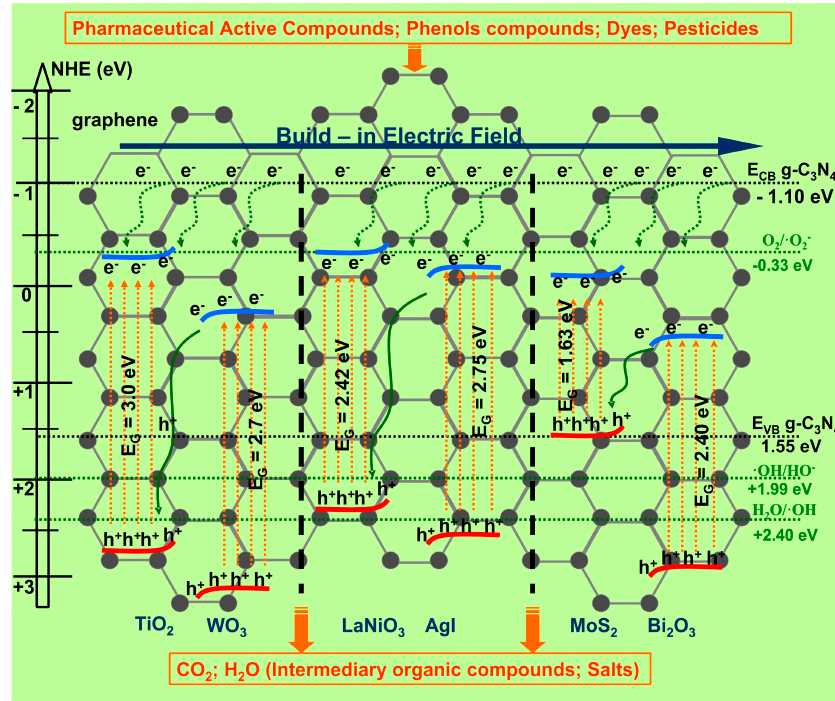
Figure 3. Energy band diagrams of TiO 2 /WO 3 , LaNiO 3 /AgI, and MoS 2 /Bi 2 O 3 S-scheme hetero- structures including the graphene structure (gray dots) and g-C 3 N 4 band energy potential (black dots lines).